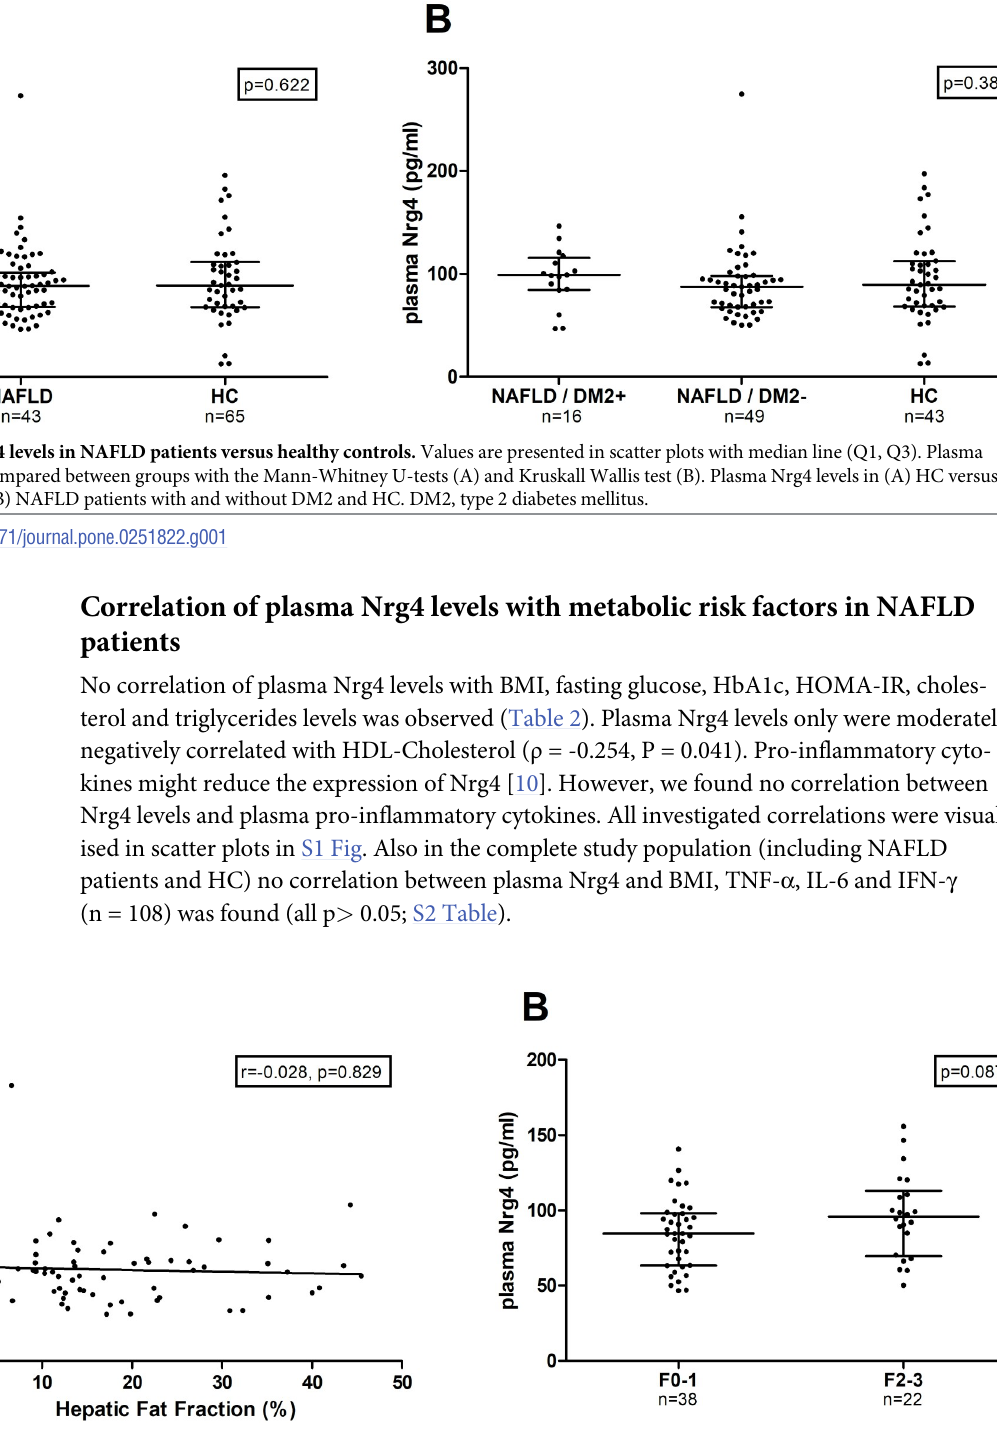
Fig 2. Association between plasma Nrg4 levels and NAFLD severity. Values are presented in scatter plots with median line and (Q1, Q3). Spearman correlation was used for correlation analysis and Mann-Whitney U-tests for comparison between two groups. (A) Spearman correlation between hepatic fat fraction and plasma Nrg4 levels in NAFLD patients. (B) Plasma Nrg4 levels in NAFLD patients without clinically significant hepatic fibrosis (F0-1), versus NAFLD patients with clinically significant hepatic fibrosis (F2-3).